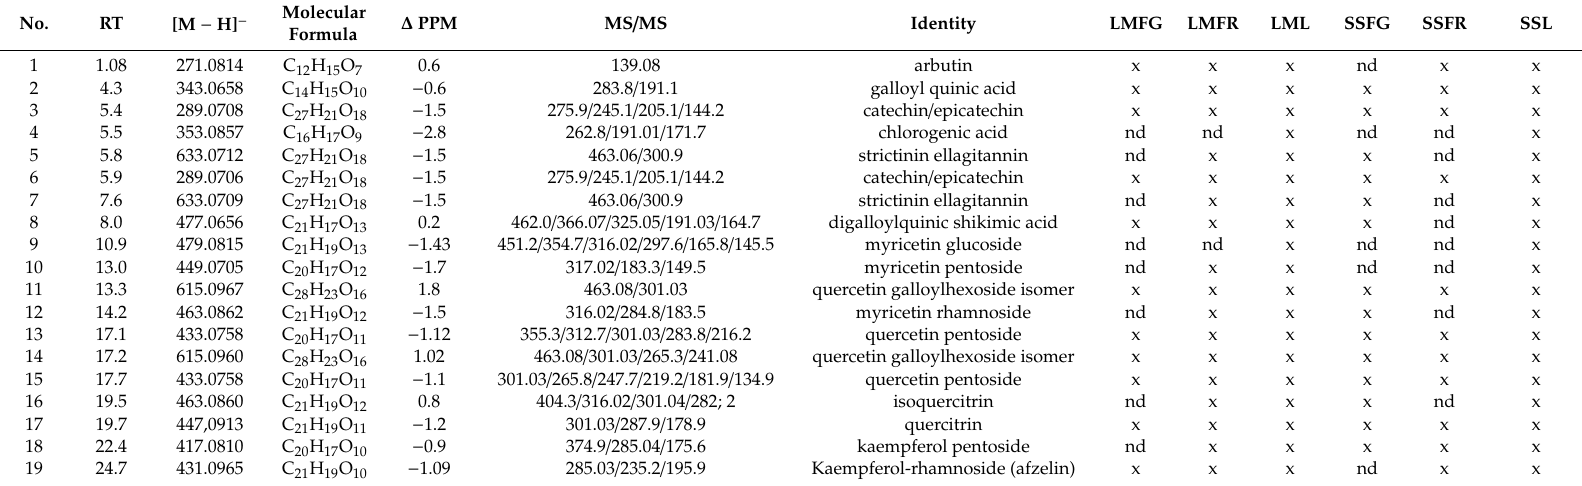
Table 1. Metabolites identified in A. unedo leaves and fruit extracts by LC–ESI / LTQOrbitrap / MS and LC–ESI / LTQOrbitrap / MS / MS analysis. (x = present; nd = not